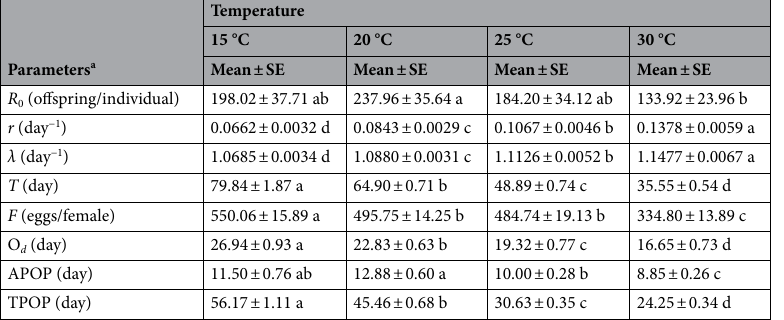
values were 0.1378 d −1 and 1.1477 d −1 , respectively, at 30 °C. The shortest mean generation time (35.55 d) was obtained at 30 °C. The lowest r and λ values (0.0662 d −1 and 1.0685 d −1 ) and the longest generation time (79.84 d) were observed at 15 °C. The net reproductive rate, R 0 , was significantly higher (237.96) at 20 °C when compared with other temperatures. The mean fecundity and oviposition days decreased with warming temperatures. Fecundity was highest at 15 °C with 550.06 eggs per female, which decreased as the temperature increased i.e., 495.75 eggs at 20 °C, 484.74 eggs at 25 °C, and 334.80 eggs at 30 °C. The oviposition days were significantly shortest at 30 °C with 16.65 d and longest at 15 °C with 26.94 d. Temperature impacts were obvious on the adult pre-oviposition period (APOP) and total pre-oviposition period (TPOP) (Table 2). APOP of females lasted shortest at 30 °C (i.e., 8.85 days) and longest at 20 °C (i.e., 12.88 d). TPOP was shortest at 30 °C (i.e., 24.25 d) and colder temperatures prolonged it from 56.17 d at 15 °C to 45.46 d at 20 °C, and 30.63 d at 25 °C. Figure 1 shows l x (age-specific survival rate), m x (total fecundity of population), and l x m x (net maternity) of H. axyridis population fed with S. litura eggs. The effects of temperature were observed on all the mentioned parameters. The l x is described as the simple form of the s xj curves. The age-specific survival rate of H. axyridis population fed with S. litura eggs at 15 °C decreased to 0.92 on the 47th d when the first fecundity occurred. At 20 °C, the first fecundity was obtained on the 42nd d with 0.92 survival rates. The fecundity of the population was seen early at 25 °C on the 27th d with 0.82 lx and 22nd d with survival rate decreasing to 0.76 at 30 °C. The l x m x curves depended on l x and m x values. The highest l x m x peaks in H. axyridis populations were 5.24 (on 70th d), 6.18 (on 78th d), 5.44 (on 58th d) and 7.32 (on 39th) (Fig. 1). The e xj (age-stage life expectancy) of H. axyridis fed with S. litura eggs at four constant temperatures are plot- ted in Supplementary Fig. S2. The e xj estimates the length of duration of the newly hatched individual. Results showed temperature impacts e xj curve of H. axyridis , but with varied degrees, i.e. highest life expectancy values for females and males were 111.61 d and 93.32 d at 15 °C, 84.83 d and 75.96 d at 20 °C, 72.21 d and 63.46 d at